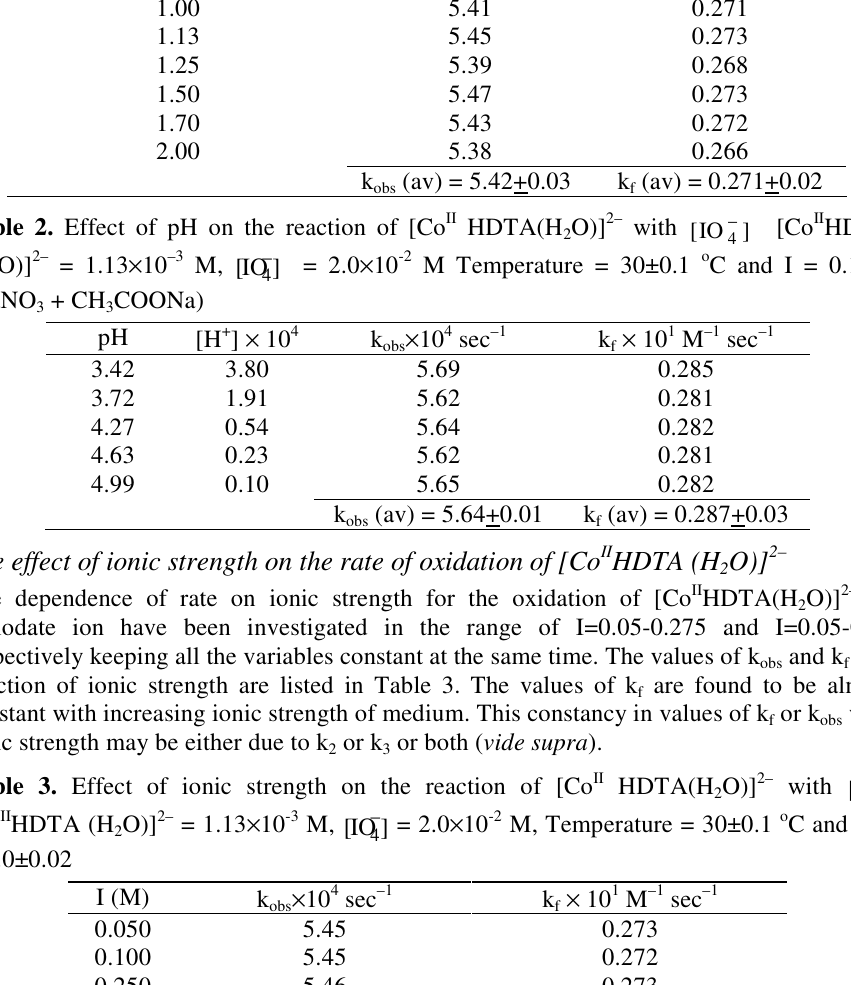
− = 2.0 × 10 -2 M, 4 COONa + NaNO ) 3 3